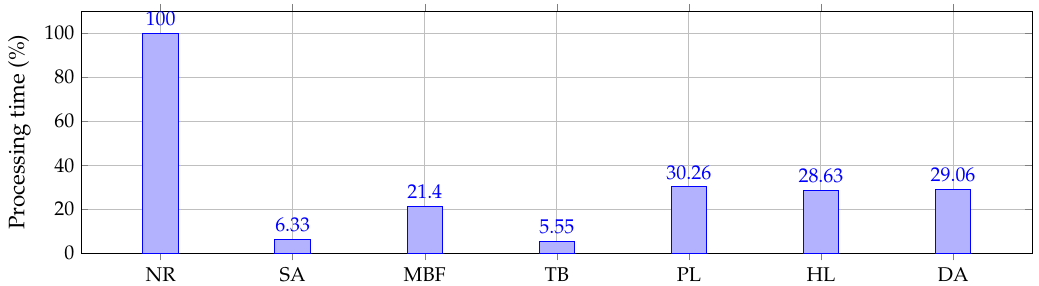
Figure 4. Processing time comparison for each studied power flow method when compared with the classical Newton– Raphson method in the IEEE 34-bus system.